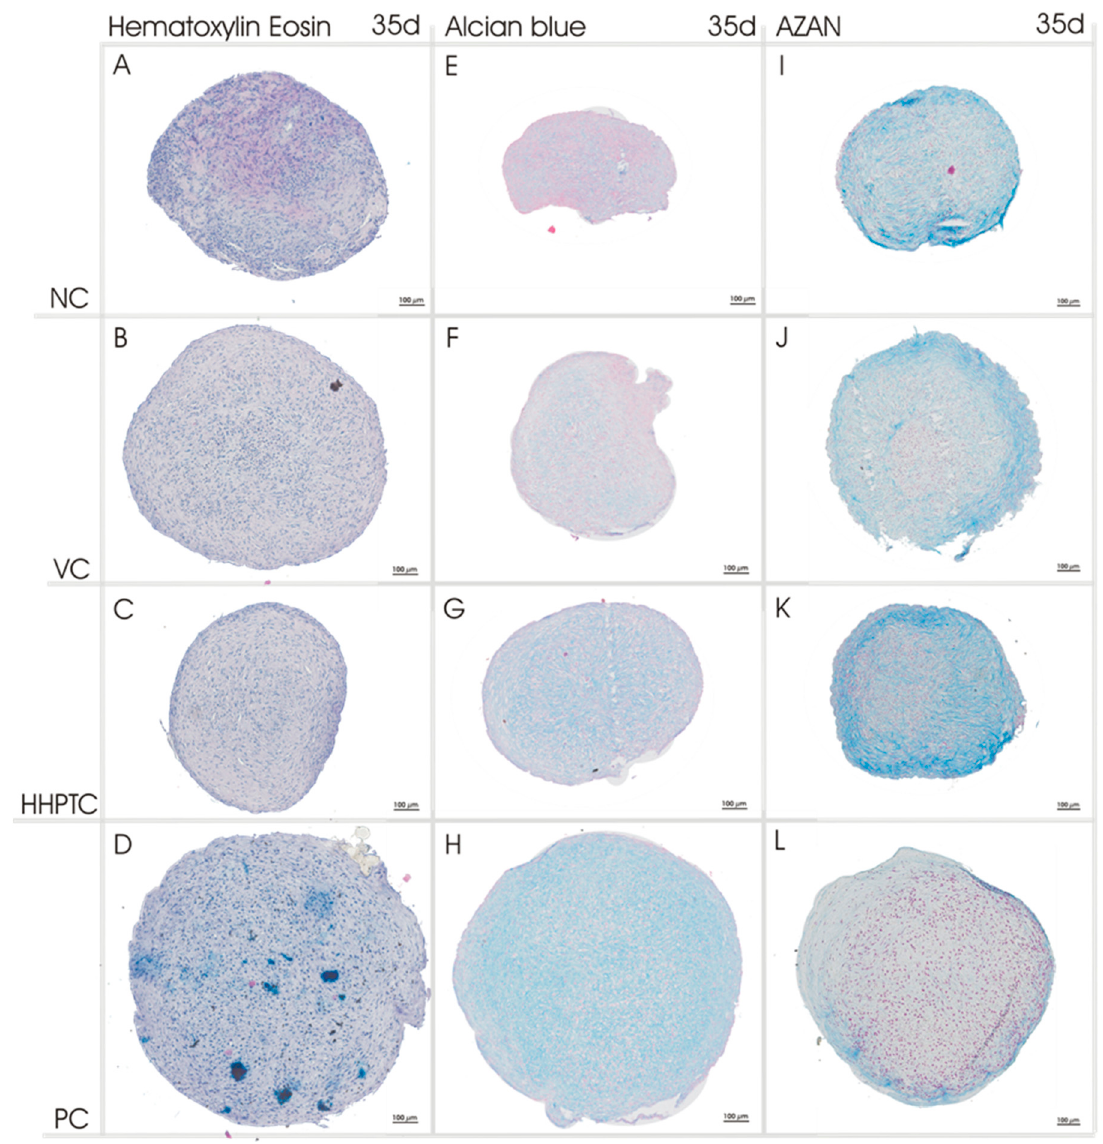
Figure 6. Representative pictures of HE, Alcian blue and Heidenhain’s AZAN trichrome staining of chondrocytic spheroid cultures. Histological staining of chondrocytic spheroid cultures was performed after 35 days of cultivation with different medium groups: Negative control (NC) ( A , E , I ), vital cartilage conditioned medium (VC) ( B , F , J ), high hydrostatic pressure treated cartilage conditioned medium (HHPTC) ( C , G , K ) and positive control (with chondrogenic growth factors, PC) ( D , H , L ). n = 12, scale bar: 100 μ m.